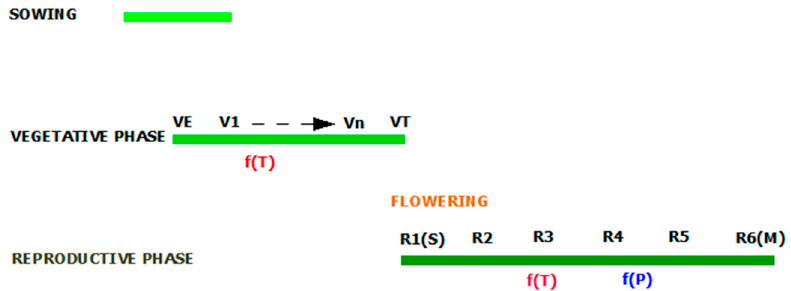
Figure 3. The maize phenology stages considered in this study.